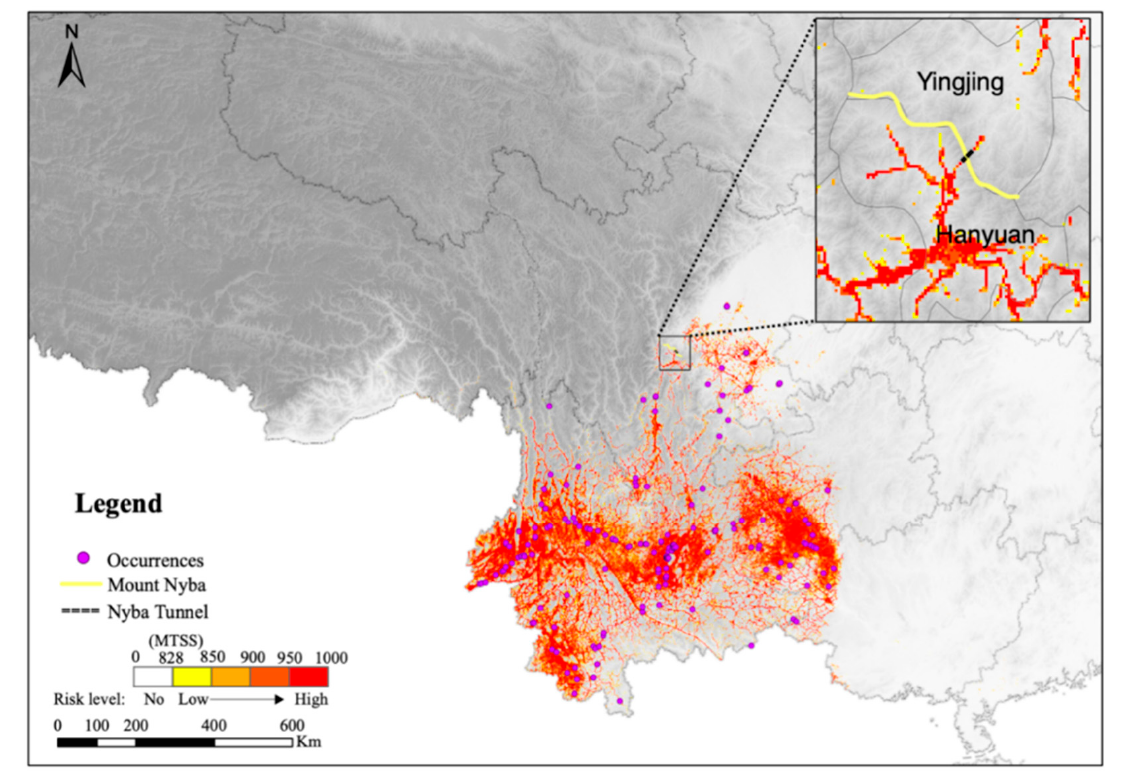
Figure 2. Suitable habitats of A. adenophora predicted using ensemble model within study area. Table 1. Permutation importance of the variables used in the modeling for A. adenophora (resolution: 1 km × 1